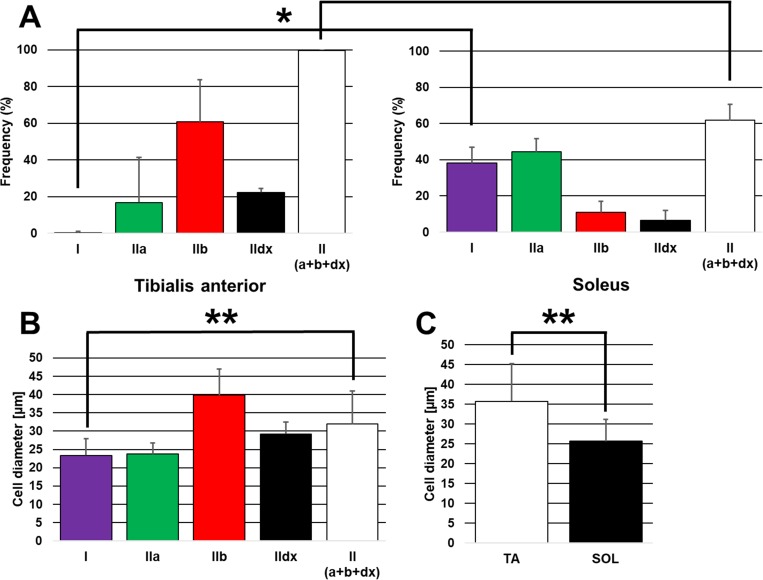
Quantification of the immunohistological findings.A: Frequency according to MHC type in each muscle. The frequency of MHC type I cells was significantly higher in the soleus muscle (SOL) than in the tibialis anterior muscle (TA), whereas the frequency of MHC type II cells was significantly higher in TA than in SOL. B: Cell diameter according to MHC type in TA and SOL. The mean diameter of MHC type I cells was significantly lower than that of MHC type II cells of TA and SOL. C: General cell diameter in each muscle (TA and SOL). The mean cell diameter in the TA was significantly higher than that in the SOL. The end of the whisker represents standard deviation. *P < 0.05; **P < 0.01.